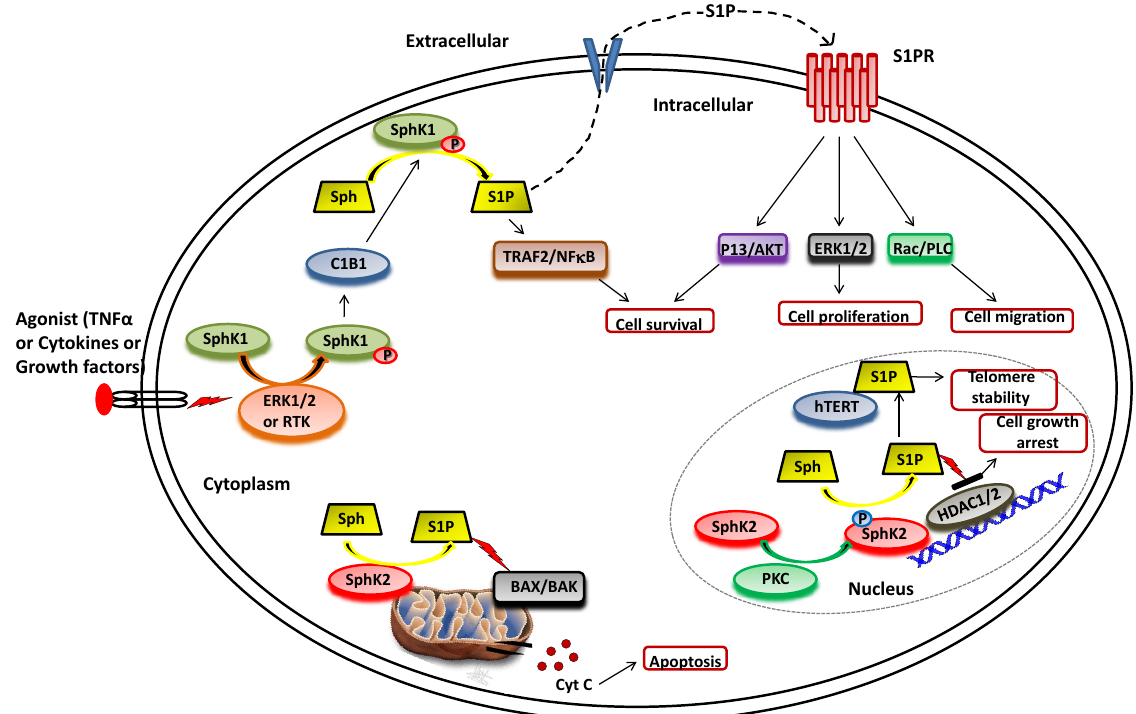
Figure 2. Functional roles of SphKs and S1P in cells. Upon ERK1/2 mediated phosphorylation/activation in the presence of various agonist (such as TNF α , cytokines and diverse growth factors), SphK1 is translocated to plasma membrane from cytoplasm and interact with calcium-myristoyl switch protein 1 (C1B1). This facilitates the phosphorylation of sphingosine to generate S1P, which can either be secreted out or interacts with intracellular targets (such as TRAF2) to elicit its functions. Once secreted out of the cell, S1P binds to the S1P receptor (S1PR) embedded in the plasma membrane and activates various downstream signaling pathways that control cell survival, proliferation, and migration. In the nucleus, SphK2 catalyzes the phosphorylation of sphingosine to generate S1P that inhibits the activity of histone deacetylases (HDAC1/2) and regulates gene expression. S1P also binds to human telomerase reverse transcriptase (hTERT) at the nuclear periphery in human and mouse fibroblasts that inhibits its interaction with makorin ring finger protein 1 (MKRN1) and promotes telomerase stability. S1P is also produced in the mitochondria by the action of